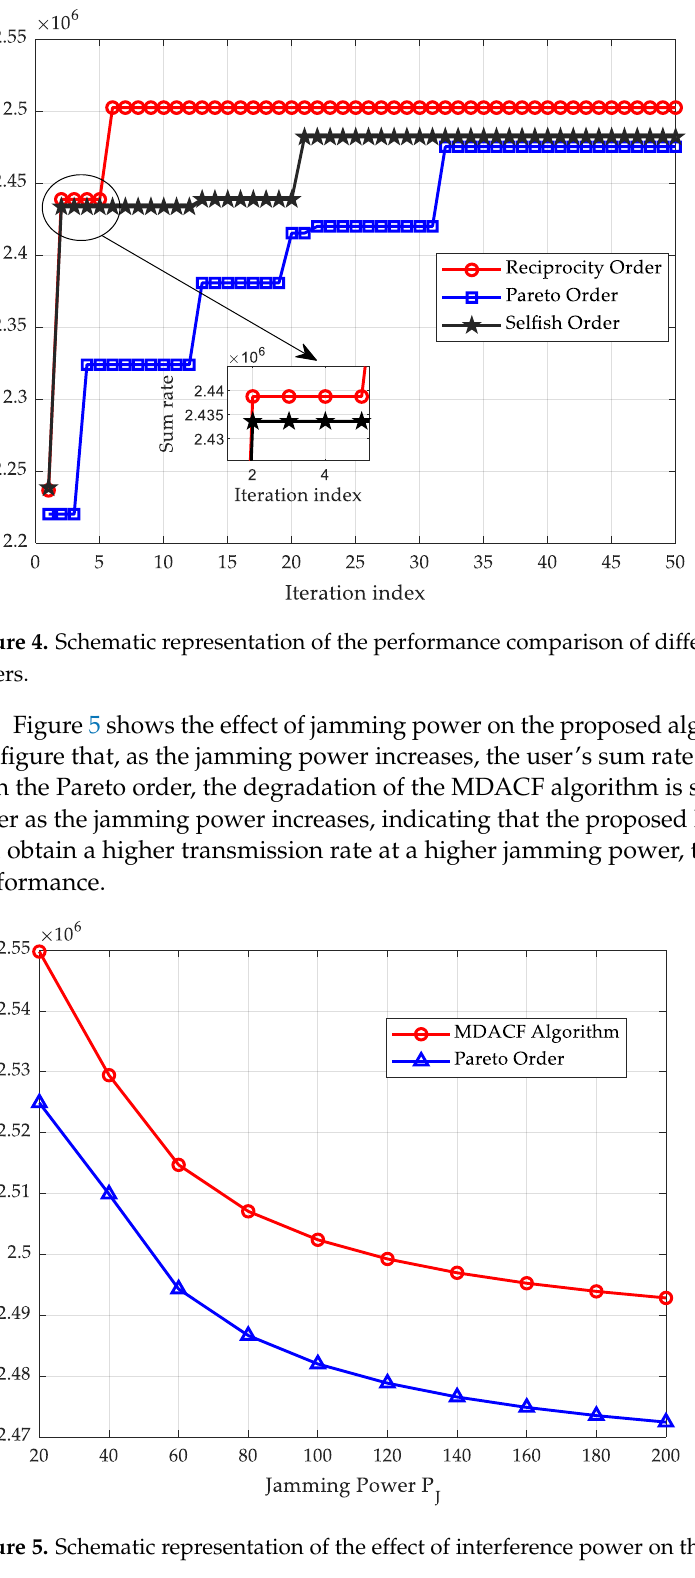
( b ) Figure 3. Schematic diagram of the change in coalition before and after using the MDACF algorithm: ( a ) before using MDACF algorithm; ( b ) after using MDACF algorithm.